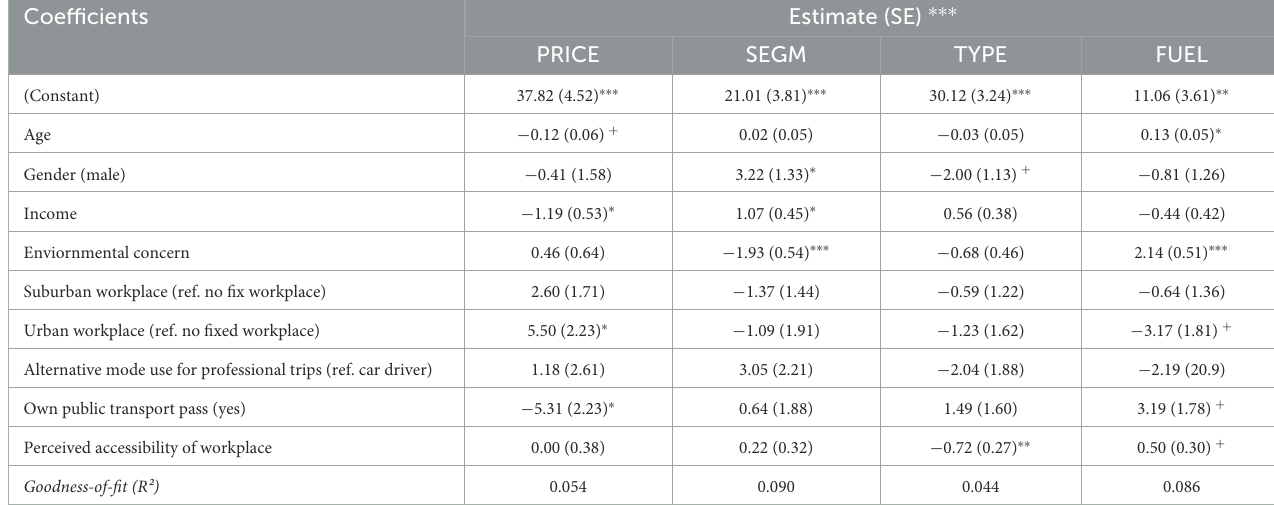
TABLE 3 Socio-demographic variables and mobility related factors as predictors of the relative importance scores for the attributes price, segment, fuel card, and engine type of company cars, using linear regression.